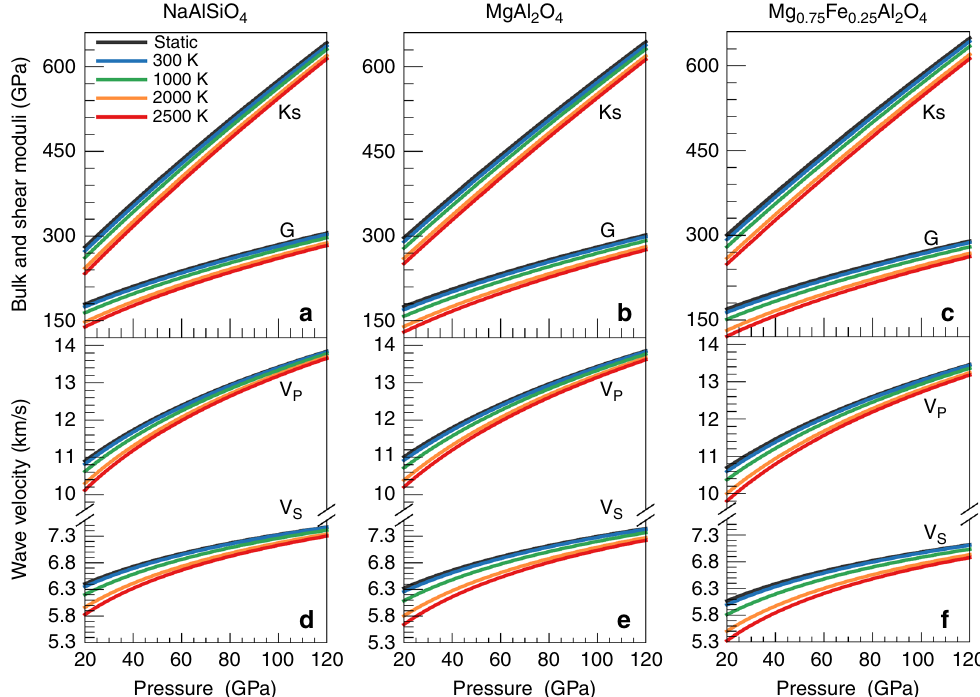
Fig. 2 Elastic moduli and wave velocities of CF-type phases. a – c bulk and shear moduli (K S and G), d – f compressional and shear wave velocities (V P and V S ). Elastic moduli and wave velocities for a , d NaAlSiO 4 , b , e MgAl 2 O 4 , c , f Mg 0.75 Fe 0.25 Al 2 O 4 .